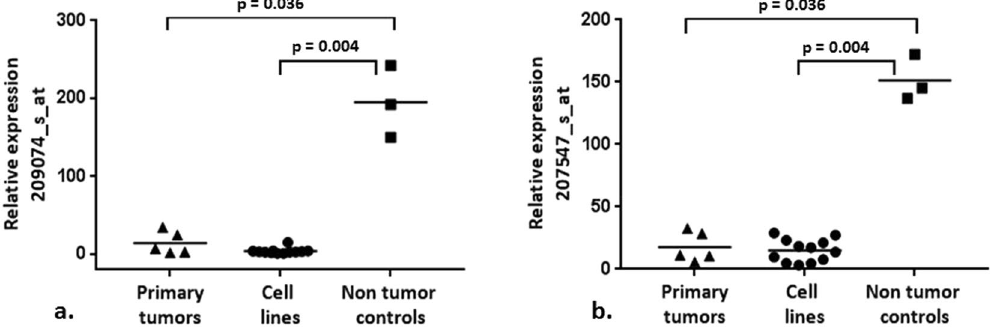
Figure 1. The relative expression of FAM107A indicated by two tags – ( a ) 209074_s_at and ( b ) 207547_s_at. Significantly downregulated expression of FAM107A in laryngeal primary tumors and cell lines is shown (p < 0.05; U Mann Whitney test; GraphPad Prism 7 demo